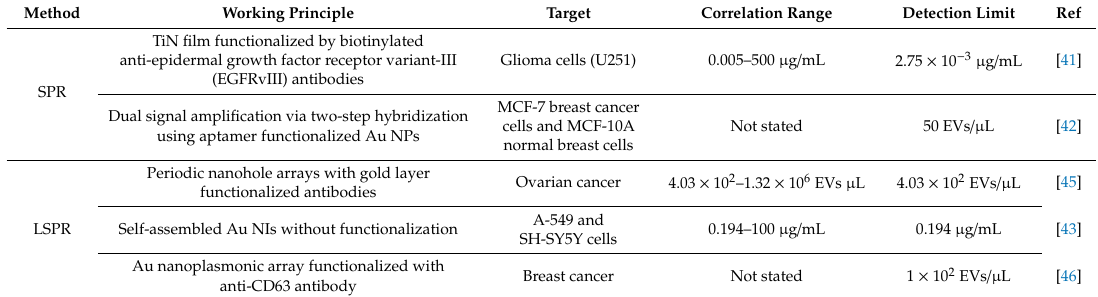
Table 1. Comparison of Surface Plasmon Resonance (SPR)-Based Bionano Sensors for EV Detection.